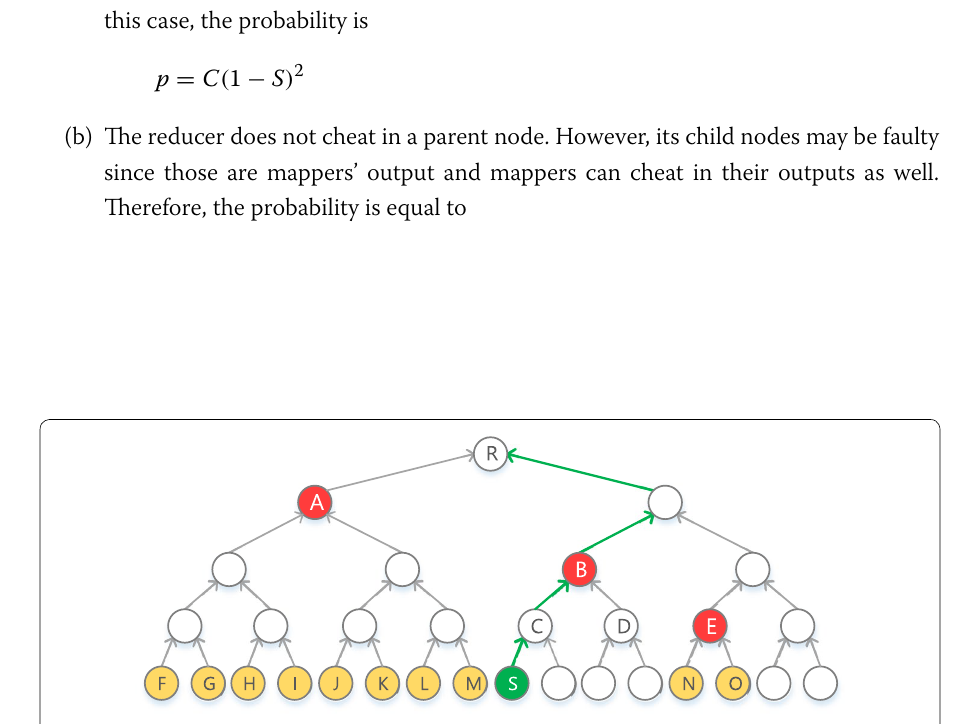
Fig. 7 Example of different places to cheat in a reduce